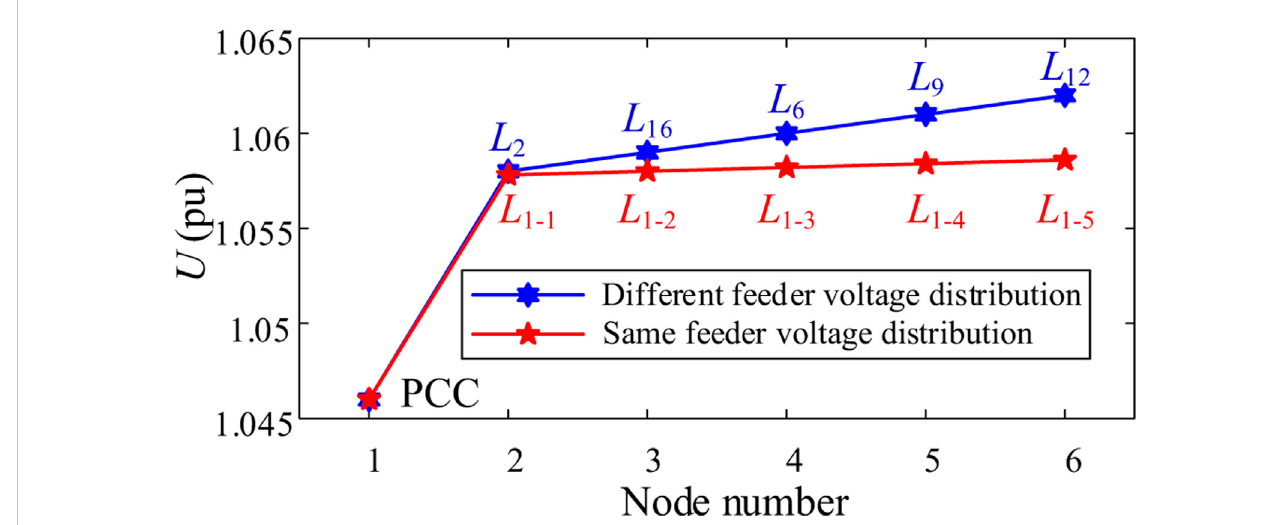
FIGURE 11 Comparison between different stability margin evaluation models and experimental results.